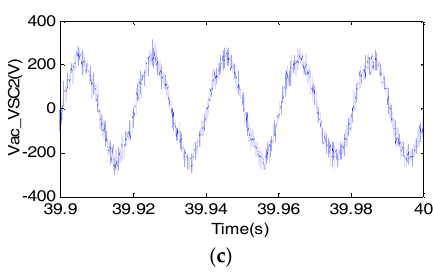
Figure 12. Experimental results of UUDAT. ( a ) DC voltages at DC terminals of VSC1 and VSC4; ( b ) DC power of VSC1 and diode bridge; ( c ) line-line AC voltage of VSC2.